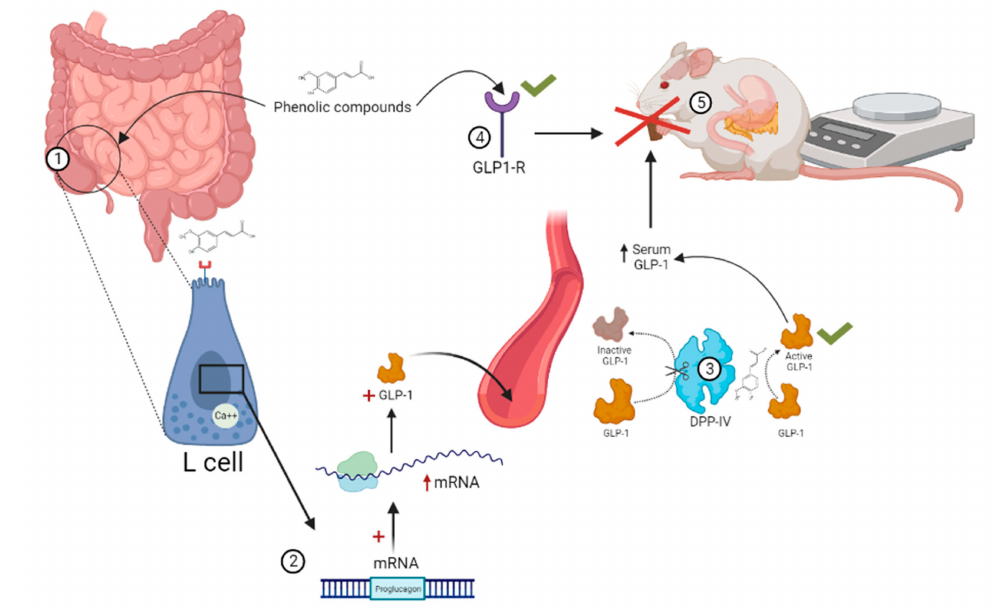
Figure 4. Potential mechanisms by which phenolic compounds can modulate GLP-1. ( 1 ) The ileum and terminal colon contain the highest density of enteroendocrine L-type cells that synthesize and secrete GLP-1. Epigallocatechin-3-gallate, ferulic acid, genistein, rutin and hispidulin have shown the ability